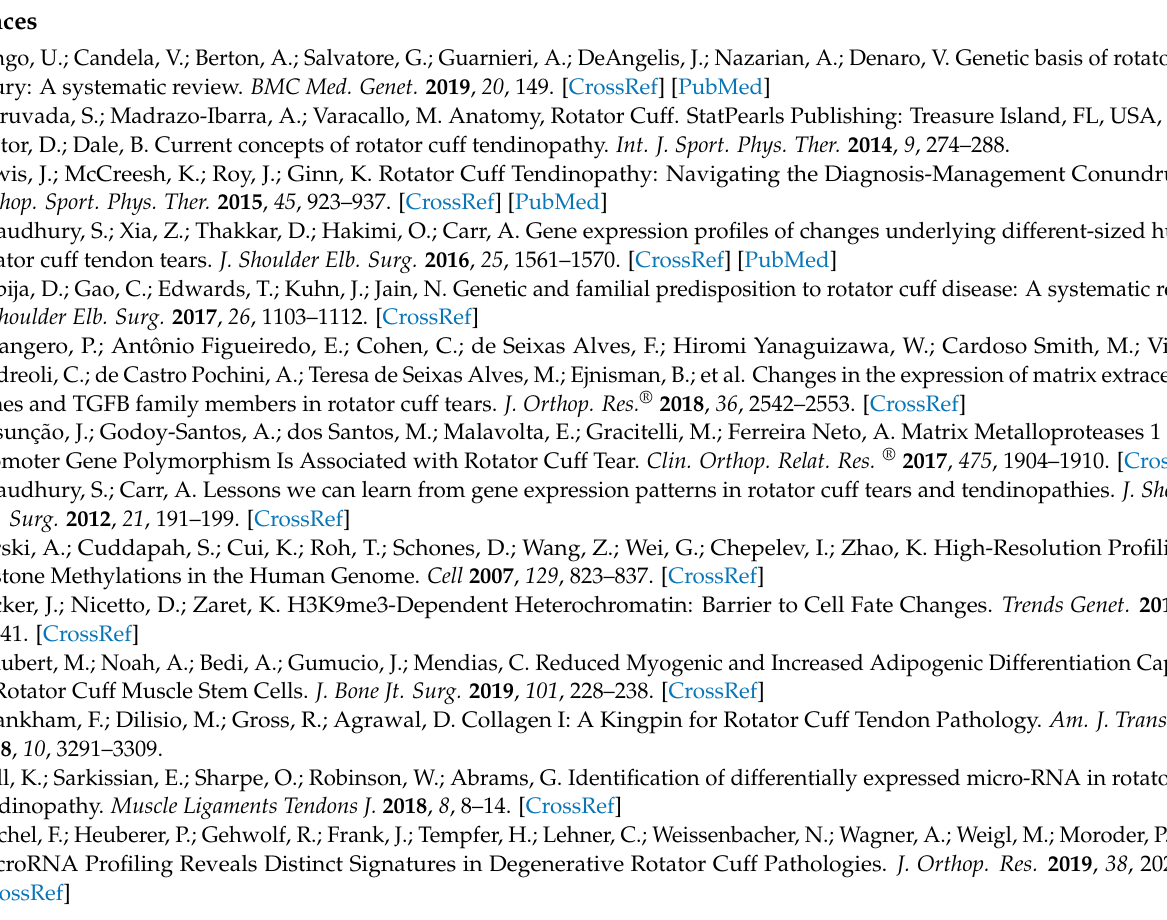
Table S3, Elution buffer; Table S4, Preparation of Invitrogen Dynabeads for immunoprecipitation; Table S5, Dilution buffer (with SDS); Table S6, Dilution buffer (without SDS); Table S7, Wash buffer I; Table S8, Wash buffer II; Table S9, Wash buffer III; Table S10, Primer combinations for semitendinosus samples; Table S11, Primer combinations for supraspinatus RCT samples; Table S12, Homer data from H3K4; Table S13, Homer data from